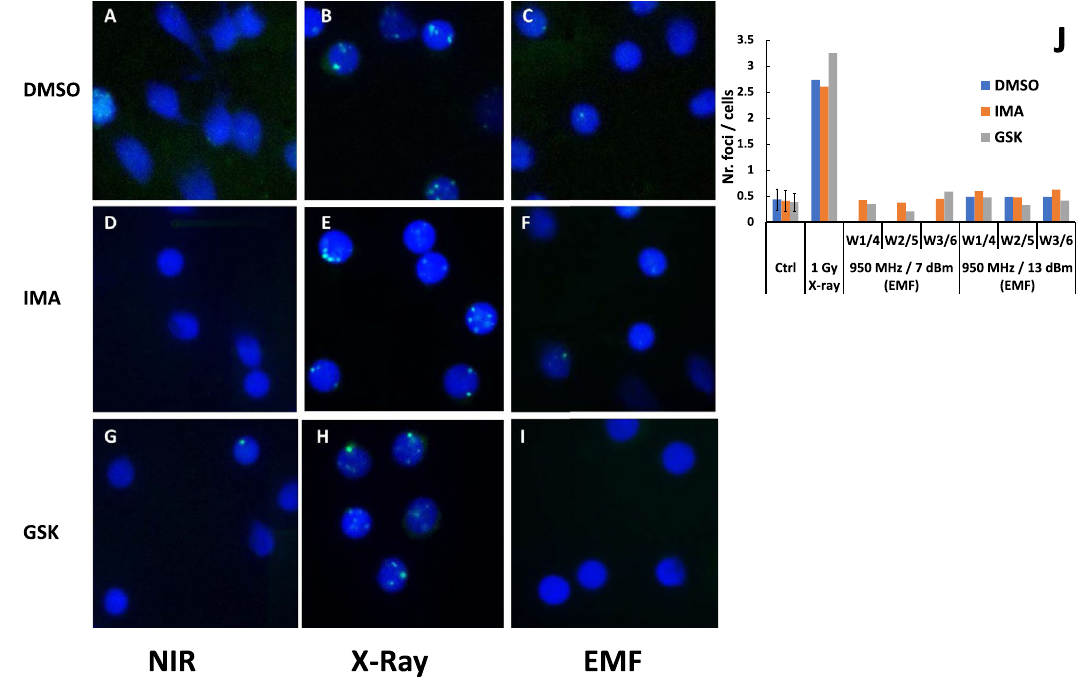
Figure 6. ( A – I ) Immuno-fluorescence detection of γH2AX phosphorylated histone foci in pre-B cells exposed to EMF or X ray irradiation. The γ H2AX foci are shown in bright green—γ-H2AX, whereas DNA staining is in blue – nuclei. ( A ) Control solvent (DMSO) treated cells Nonirradiated (NIR); ( B) Control (DMSO) treated 1 Gy X-ray irradiated cells(X-Ray); ( C ) Control (DMSO)treated EMF exposed (waves at 950 MHz, with emission generator power setting set at 7 dBm-EMF); ( D ) IMA treated NIR; ( E ) IMA, X-ray; ( F ) IMA, EMF; ( G ) GSK, NIR; ( H ) GSK, X-ray; ( I) GSK, EMF. ( J) Number of counted foci per /cell represented as histograms. W1/4 refers to growing plate wells 1 and 4, W2/5 wells 2 and 5 and W3/6 wells 3 and 6 equivalent positions with respect to which cells were EMF irradiated, with generator power setting set at 7 dBm and 13 dBm. GSK is cells treatment with 10 µM GSK-690693, IMA their treatment with 3 µM Imatinib. ANDOR camera assisted by IQ Live Cell Imaging software and foci analysis with Imaris for Cell Biologists software (both from OXFORD